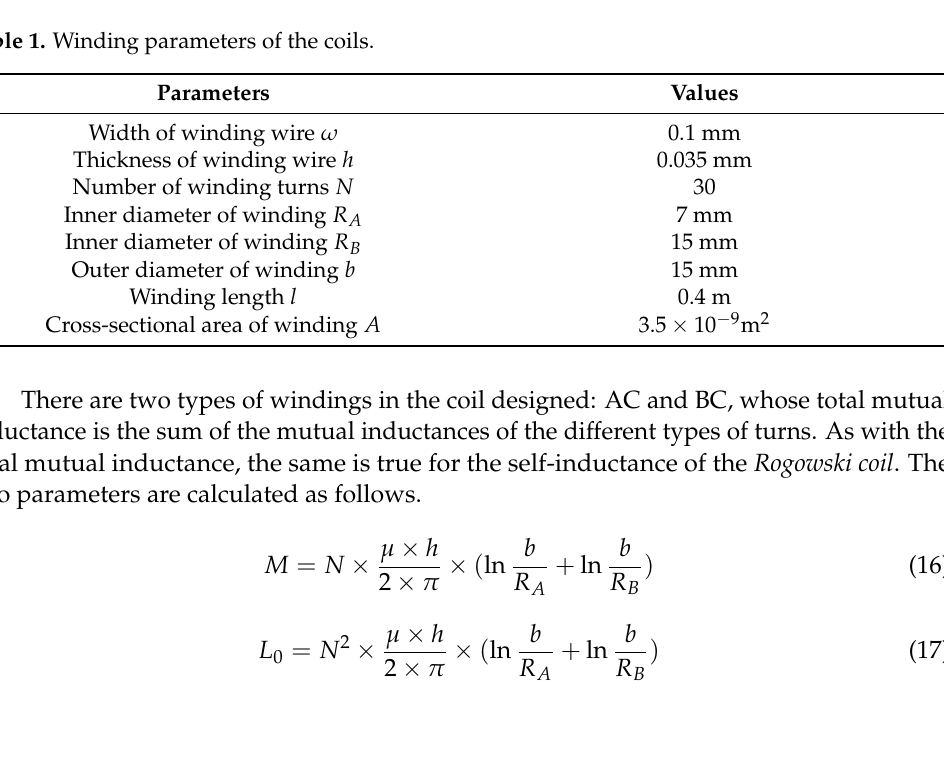
Table 1. Winding parameters of the